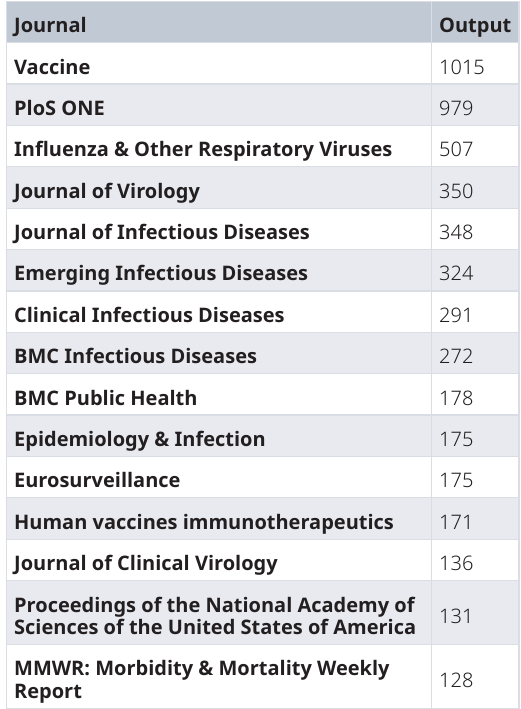
Table 2. Journals that published more than 100 research output related to influenza during